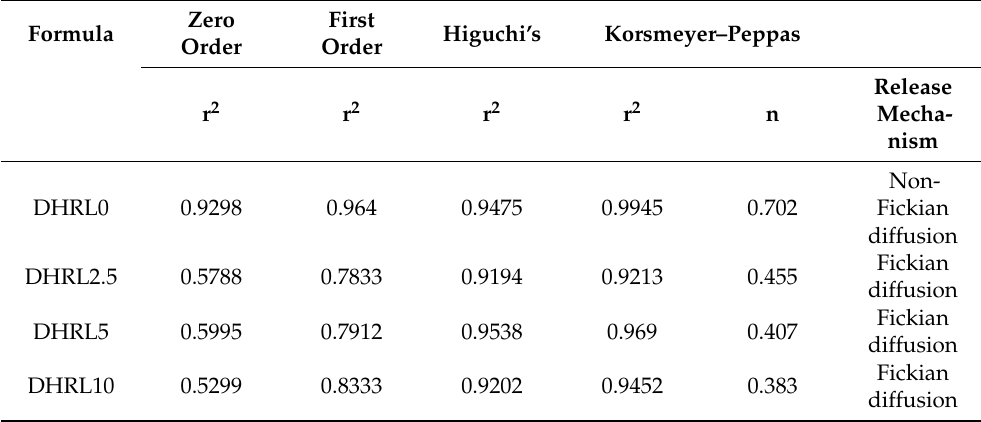
Table 2. The regression coefficient (r 2 ) value and diffusion exponent value (n) obtained from the different model fitting of the release profile of DH-loaded rosin in situ forming gel systems.